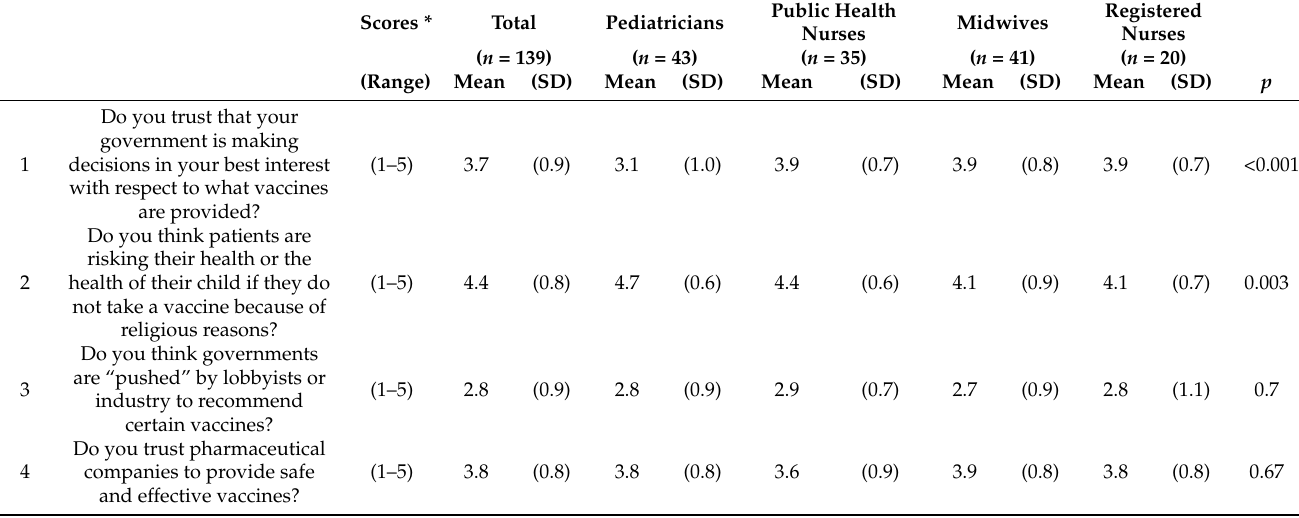
Table 4. Contextual influences among healthcare